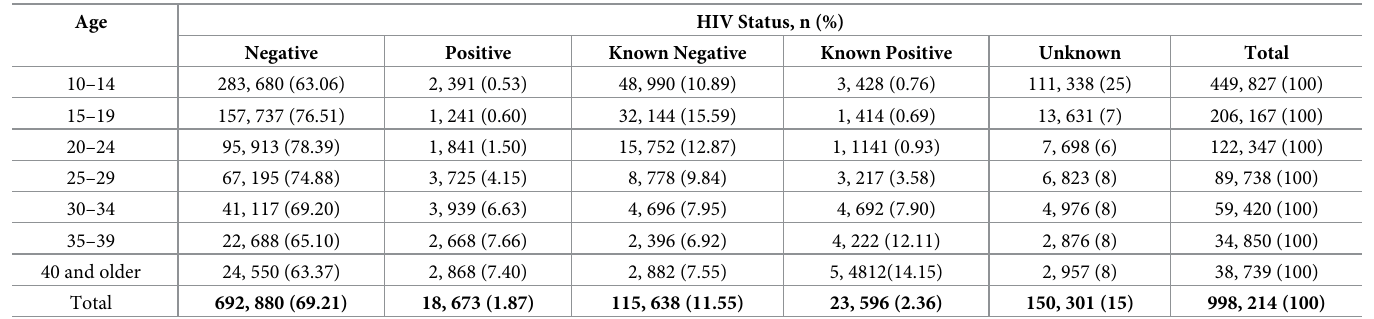
Table 2. HIV Status by age groups.